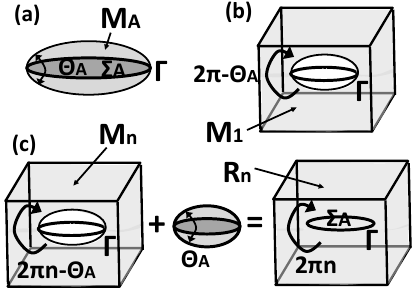
Figure 3 . Sketches of replica calculations of gravitational